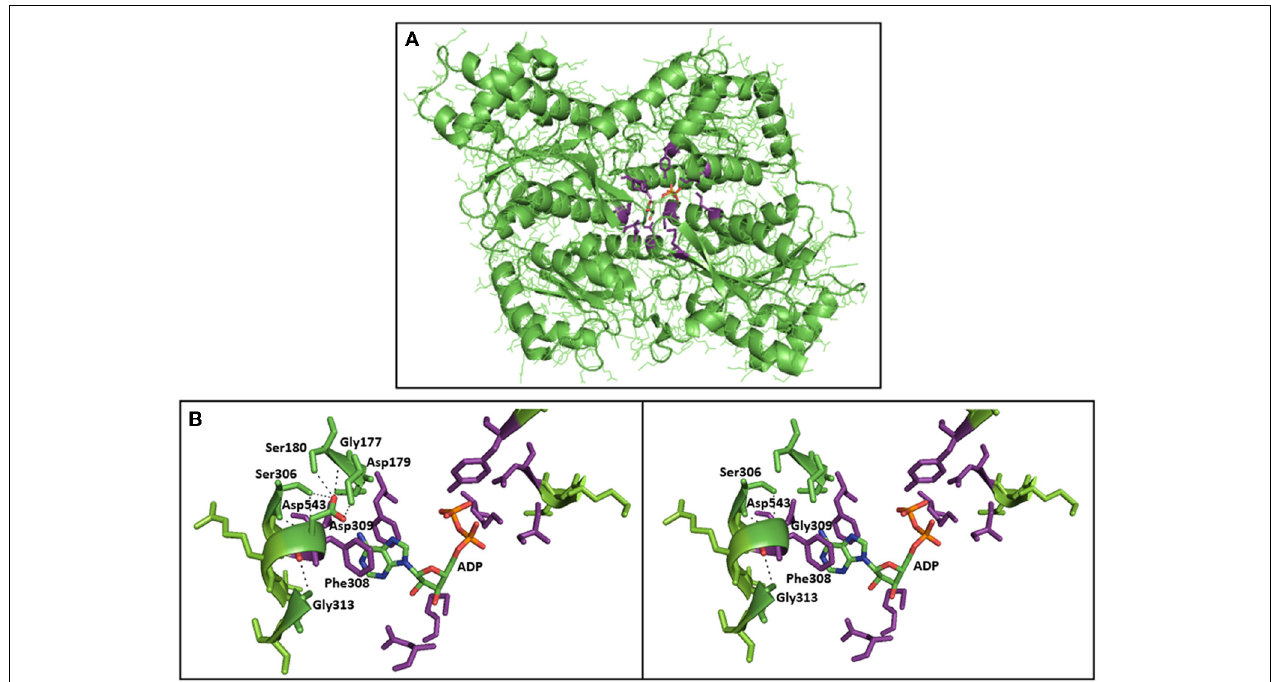
FIGURE 2 | 3D crystal structure of PFK subunit from rabbit skeletal muscle and 3D model of normal/mutated PFKM (PDB 3O8L—protein databank). (A) Allosteric nucleotide (ADP) binding site residues (purple) in the center of the rabbit subunit of PFKM, and the allosteric activator ADP are shown (atom coloring: carbon—green, nitrogen—blue, oxygen—red, phosphor—orange). (B) Close-up of the c.Asp309Gly mutation in PFKM. Asp309 is in close proximity of the ADP binding site. Asp309 does not